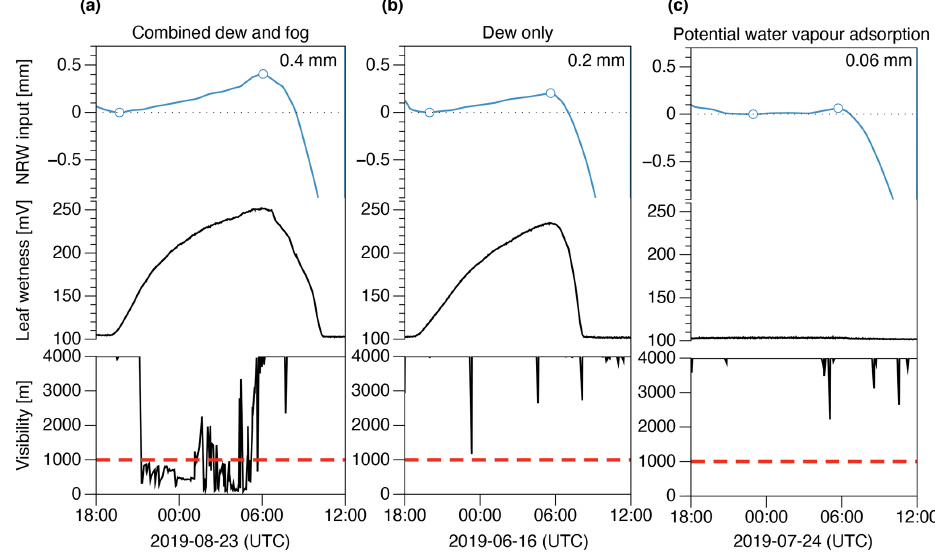
Figure 4. Differentiation of different NRW input events with the ML system and ancillary sensors. (a) Combined dew and fog event. (b) Dew- only event. (c) Potential water vapour adsorption event. The black dashed line indicates the zero line. The red dashed line is the threshold for fog events with a visibility < 1000m. Visibilities > 4000m were reported as 4000m. Blue circles indicate the start and end of NRW input events. Table 1. Cross table to indicate different criteria for differentiation among different NRW events. The “ + ” sign indicates the presence, whereas the “ − ” sign indicates the absence of a certain factor. All NRW events lead to increase in ML mass; ancillary sensors of leaf wetness, visibility, and temperature are needed to differentiate between NRW events. NRW event ML mass Leaf Visibility Temperature type increase wetness < 1000m < 0 ◦